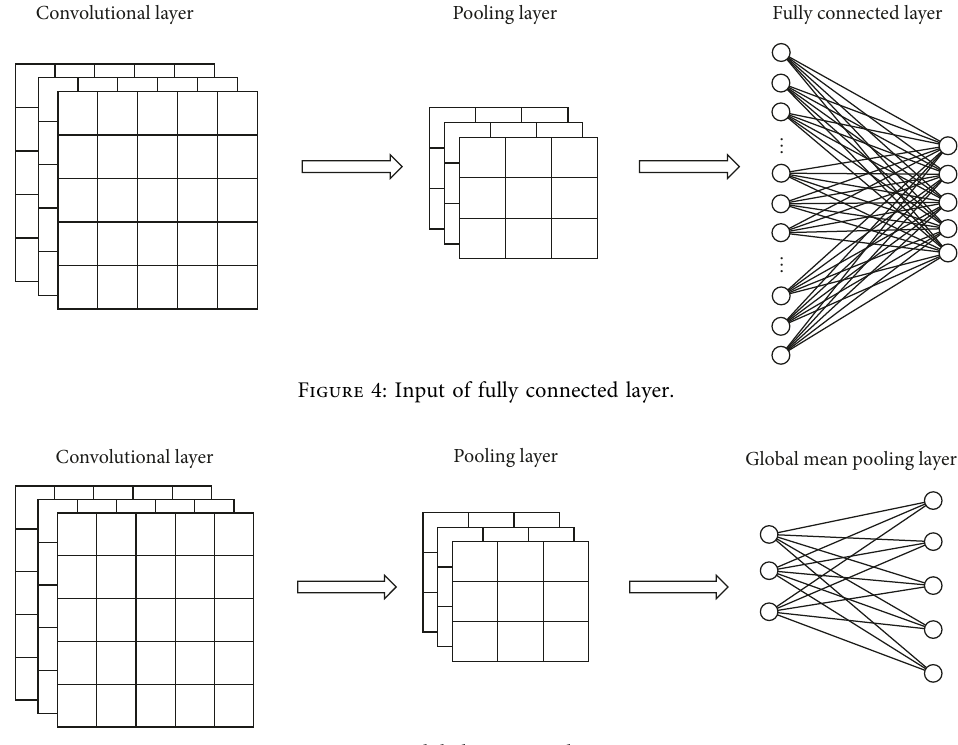
Figure 5: Global mean pooling